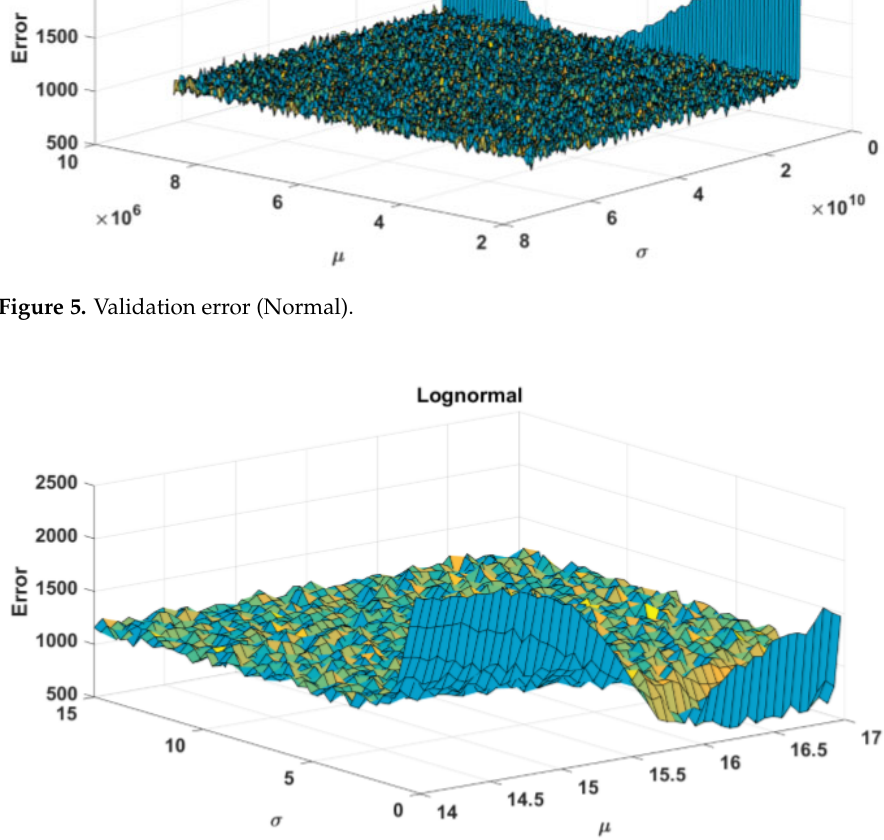
Figure 6. Validation error (Lognormal).